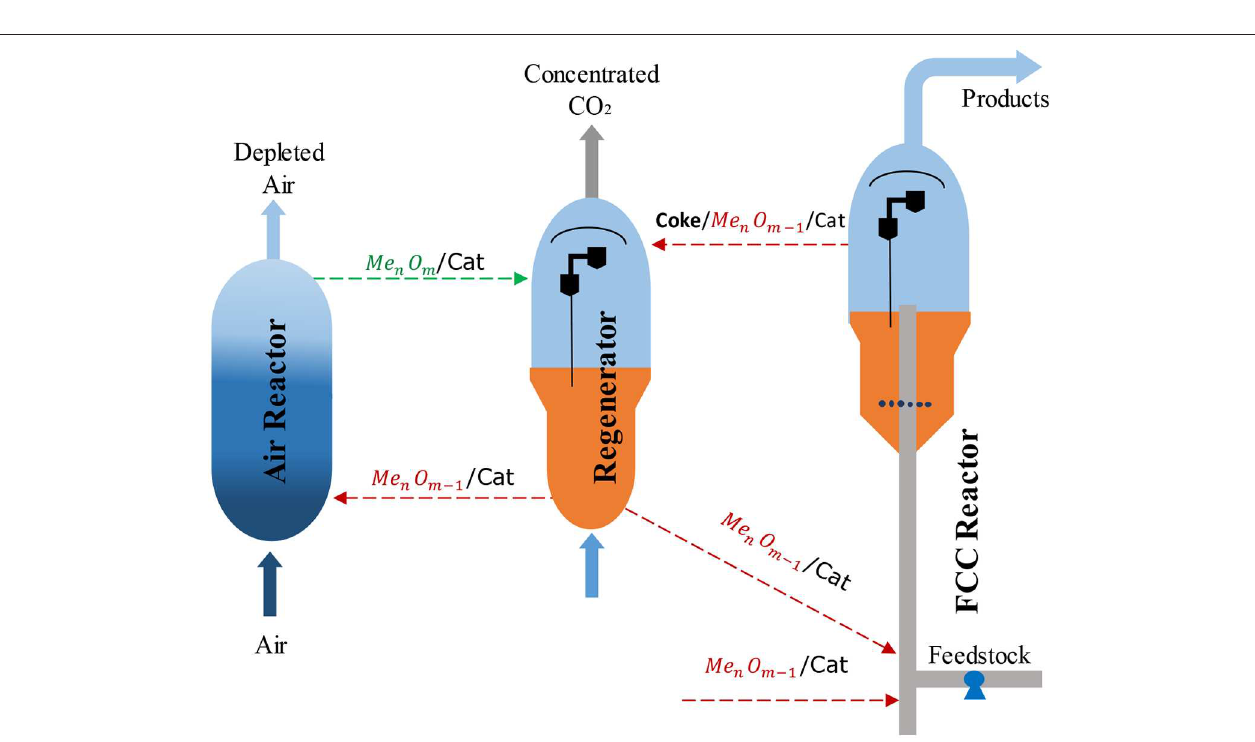
FIGURE 11 | Schematic diagram of the proposed CLC-FCC process, reprinted from Güleç et al. (2019a, 2020) with the permission from Elsevier.